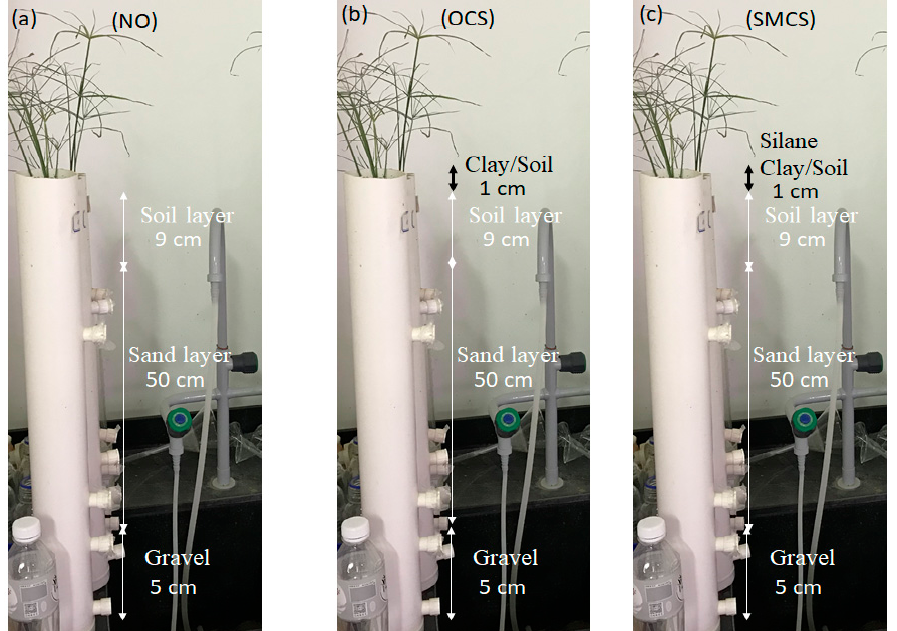
Figure 2. Schematic picture of the various bioretention columns used in this study. Abbreviation ( a ) NO (without additional layer); ( b ) OCS (additional layer of original clay and soil); ( c ) SMCS (additional layer of silane modified clay and